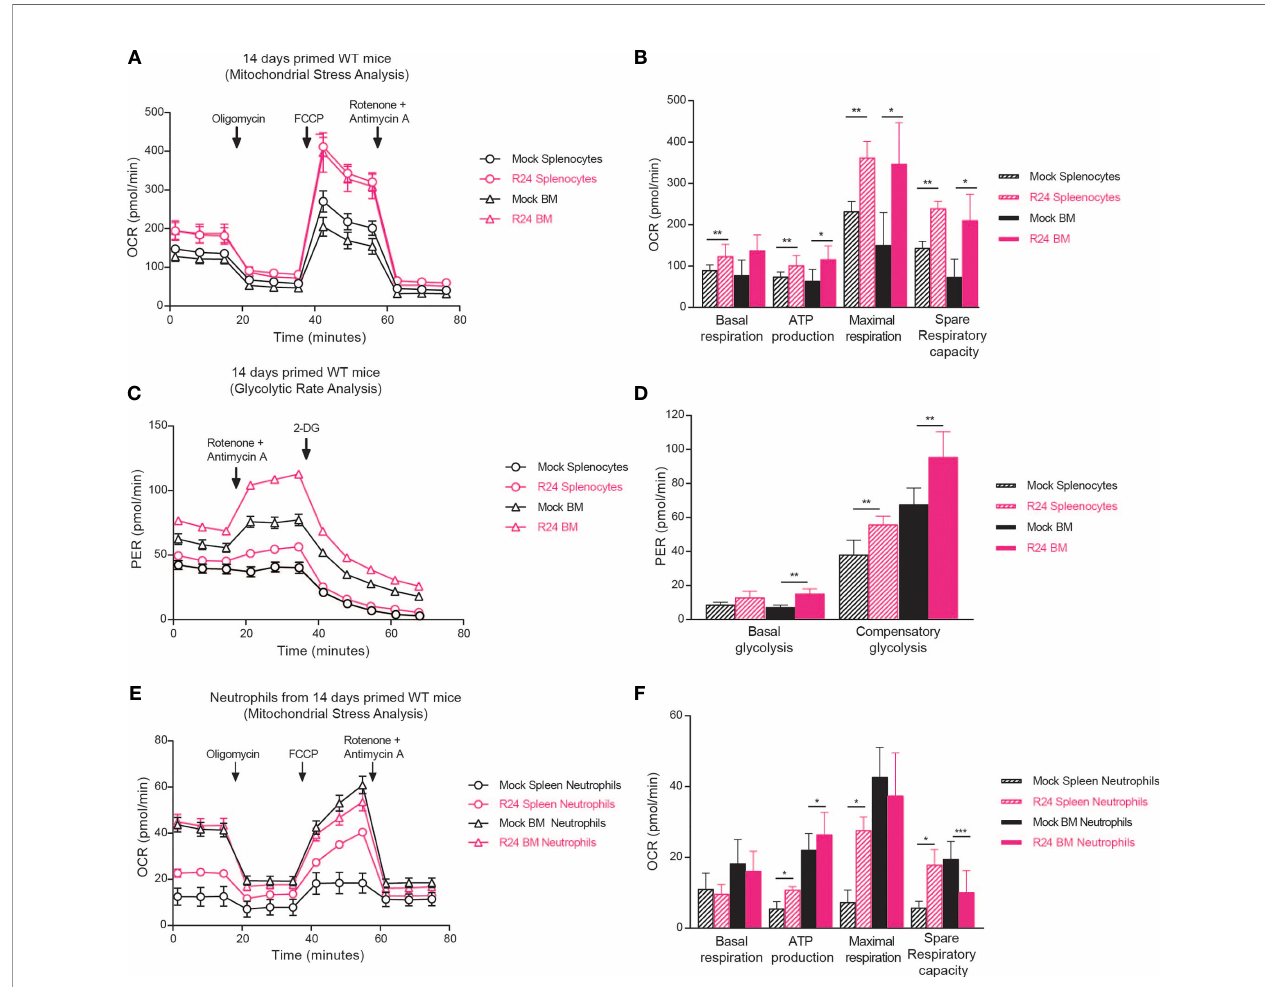
FIGURE 4 | R24 vaccination increase both mitochondrial respiration and glycolytic rate/potential. (A) Ex vivo Oxygen consumption rate (OCR) in Splenocytes and Bone Marrow cells from mice vaccinated 14 days with the gut evolved strain R24 (5x10 5 CFUs) and non-vaccinated mice. Splenocytes and BM cells were puri fi ed, plated in 96-well plates and exposed to oligomycin, FCCP, and ROT plus AA (see “ Materials and methods ” ). OCR was measured as pmol O 2 /min/µg. (B) Proton Ef fl ux Rate (PER) in Splenocytes and Bone Marrow cells from mice vaccinated 14 days with the gut evolved strain R24 (5x10 5 CFUs) or non-vaccinated mice was determined by the glycolytic rate assay as mpH/min. (C) Basal Respiration, ATP production, maximal respiration and spare respiratory capacity were obtained by the mitochondrial stress analysis and are represented as mean ± SEM of n = 5 individual samples. (D) Basal glycolysis and compensatory glycolysis were obtained by the glycolytic rate assay and are represented as mean ± SEM of n = 5 individual samples. (E) Ex vivo Oxygen Consumption Rate (OCR) in neutrophils sorted from spleens from R24 vaccinated mice and non-vaccinated mice. (F) Basal Respiration, ATP production, maximal respiration and spare respiratory capacity are represented as mean ± SEM of n = 5 individual samples. Mann-Whitney tests between R24-vaccinated and mock-immunized mice were performed using Prism v9. * P < 0.05, ** P < 0.01, *** P <